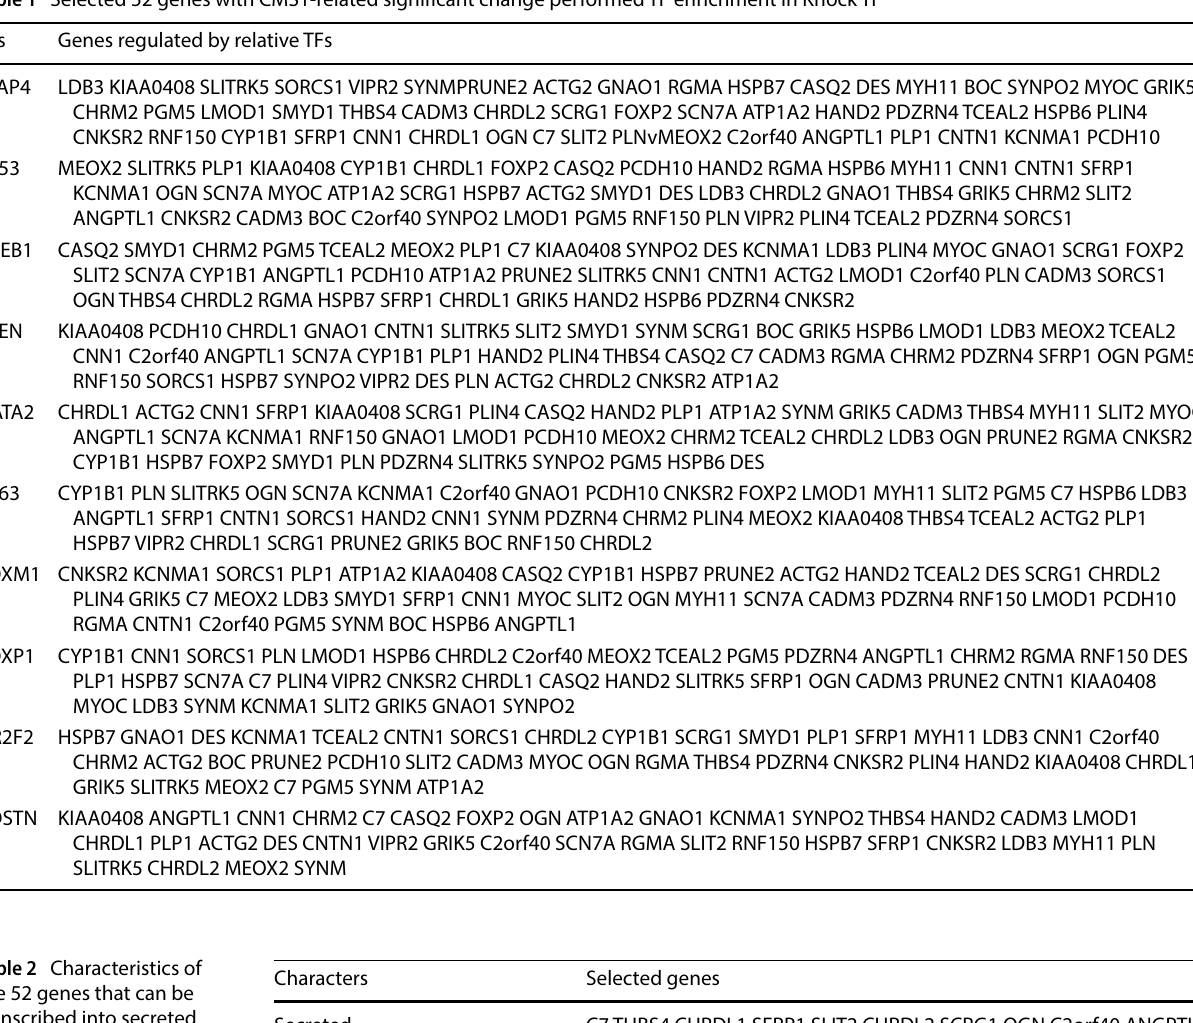
Table 1 Selected 52 genes with CMS1-related significant change performed TF enrichment in Knock TF TFs